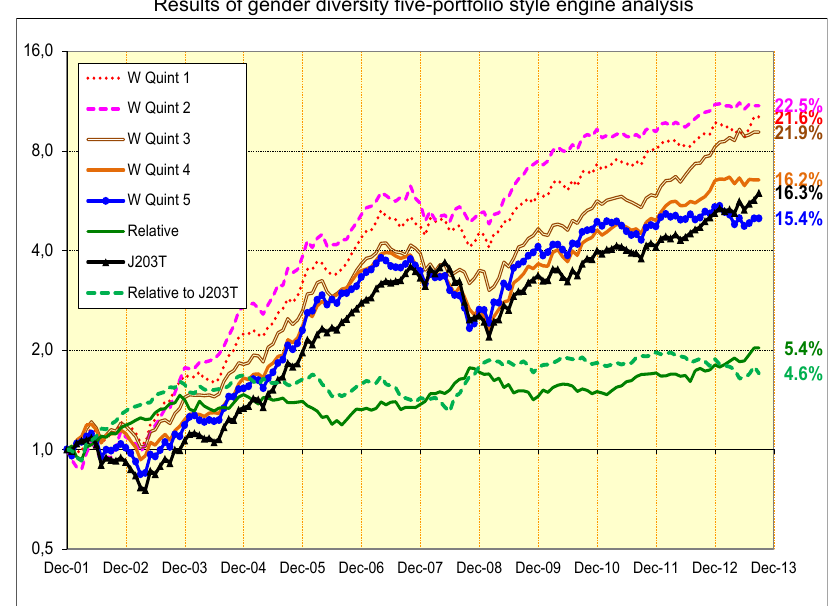
Figure 13 Results of gender diversity five-portfolio style engine